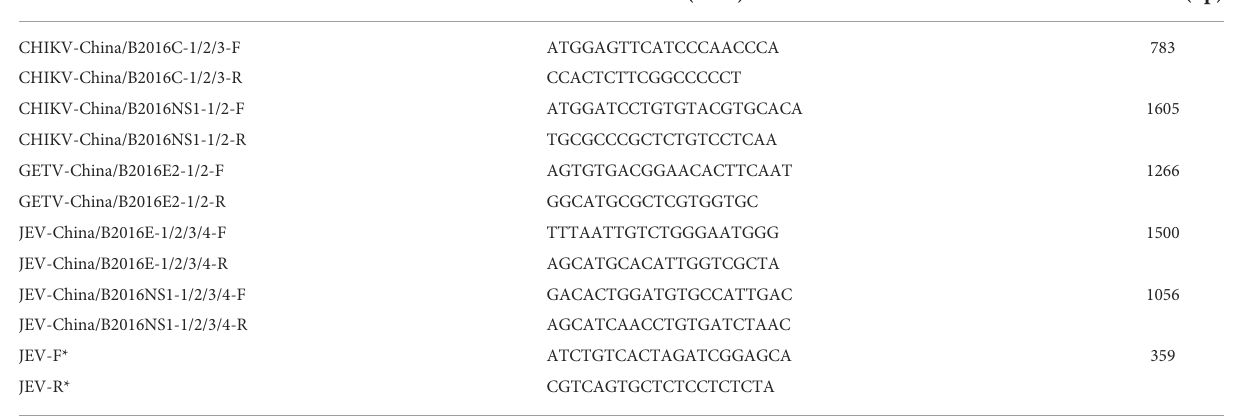
TABLE 2 Primer pairs used in PCR identi fi cation.